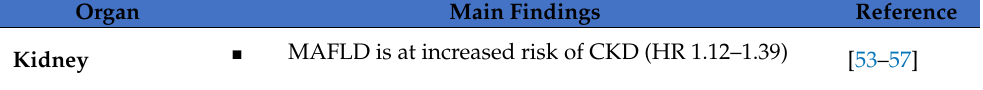
Table 3. Major findings on the relationship between MAFLD and the kidney.